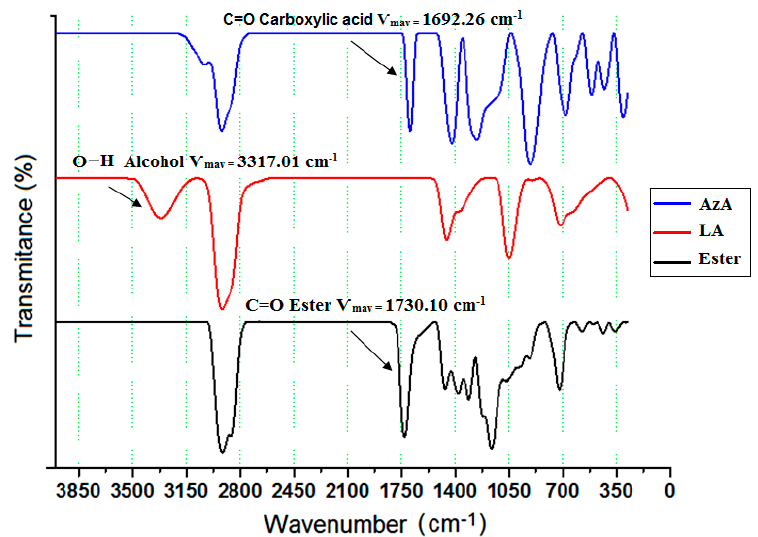
Figure 1. Infrared spectrum of dilaurylazelate ester.